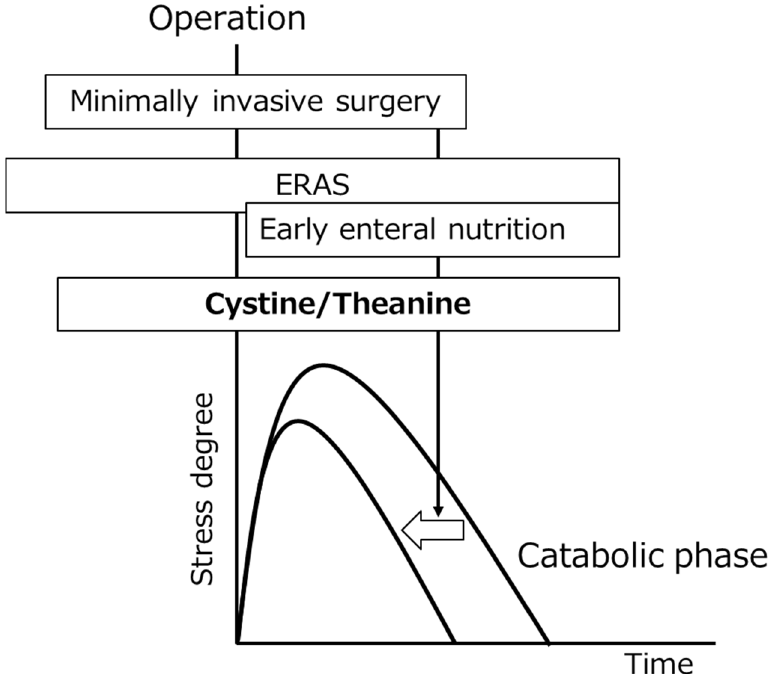
Figure 4. Perioperative management. To shorten the catabolic phase, minimally invasive surgery and nutritional therapy, including postoperative early enteral feeding (an element of ERAS) and oral intake of cystine/theanine, are effective. ERAS: enhanced recovery after surgery. The possibility of other applications of cystine/theanine has also been Author Contributions: T.T. and S.K. wrote the manuscript draft and approved the final version of